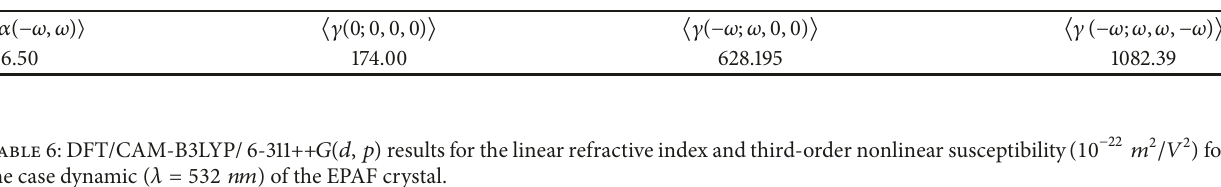
Table 5: The values of the linear polarizability (in 10 −24 esu) were calculated CAM − B 3 LYP /6 − 311 + +𝐺(𝑑, 𝑝) and for values of the second